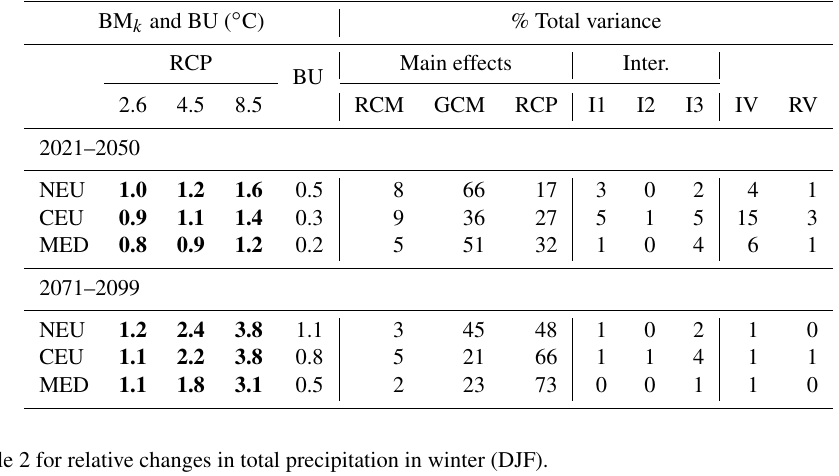
Table 2. Balanced mean change response BM k for each RCP scenario, scenario-excluded uncertainty BU, and partition of the total variance for three illustrative regions for absolute changes in mean temperature in winter (DJF) for two future periods compared to the period 1981– 2010. I1, I2, and I3 refer to RCM–GCM, RCM–RCP, and GCM–RCP interactions, respectively. IV and RV refer to internal and residual variability, respectively. Absolute mean changes greater than the uncertainty ( | BM k / BU | > 1) are indicated in bold font. 90% confidence intervals can be obtained with the expression [ BM k − 1 . 645BU , BM k − 1 . 645BU ] .